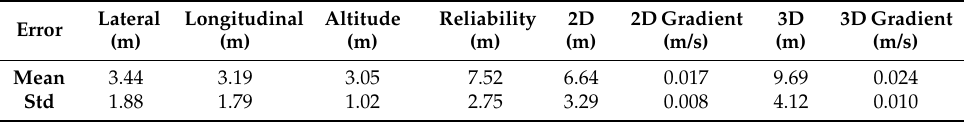
Figure 7. Experiment 1: positioning error and reliability estimation result. The top panel represents the positioning error in lateral, longitudinal and altitude directions, respectively. The bottom panel represents the estimated reliability and 3D positioning error of SLAM. Table 2. Experiment 1: Performance of NDT-based graph SLAM in a sparse area with dense traffic condition.